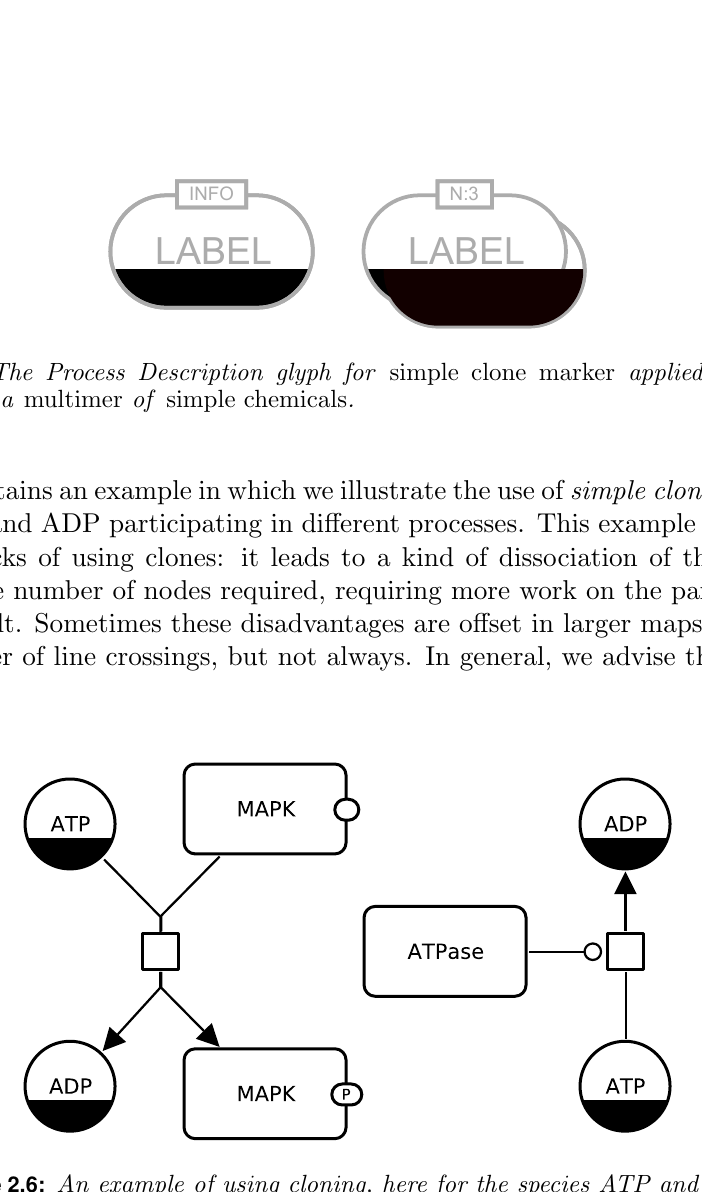
Figure 2.6: An example of using cloning, here for the species ATP and